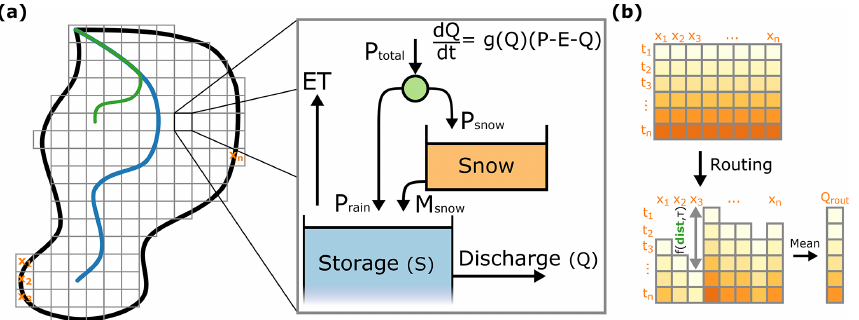
Figure 1. Efficient distributed implementation of the simple dynamical systems approach, which is solved for each pixel. The left-hand side of panel (a) represents a catchment, with a regular grid covering the catchment area. The green line indicates the flow path on which the routing lag is based (green “dist” in panel b ). Panel (b) shows how the catchment is translated to a matrix to allow for computationally efficient calculations, and how the matrix is modified in the routing algorithm, by shifting each column based on the distance to the outlet and the routing parameter τ .